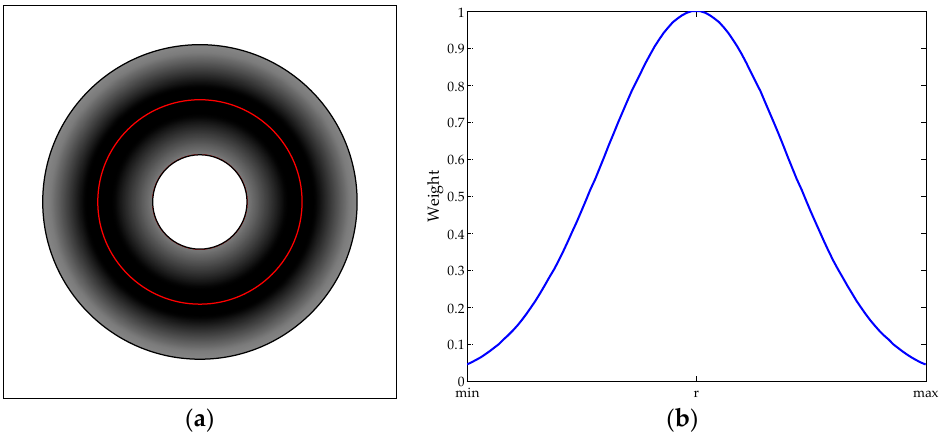
Figure 5. The model of Strategy 2 and weight assignment: ( a ) the model of Strategy 2, where the horizon circle is marked as the red part in the figure; and ( b ) weight assignment.